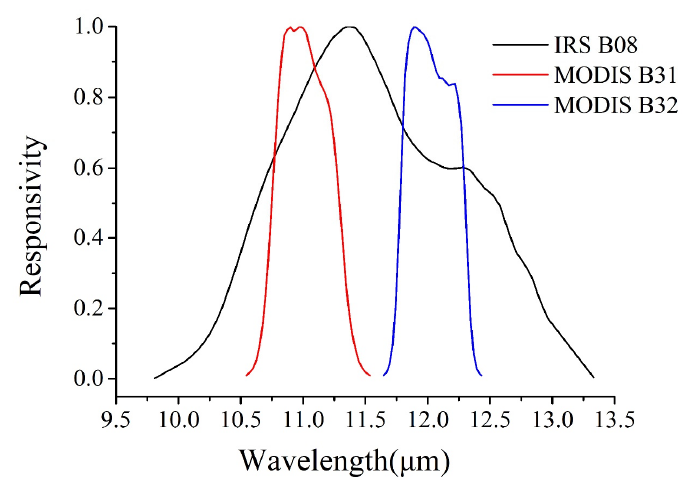
Figure 2. Comparison of channel response functions between Terra/MODIS B31 and B32 and the HJ- 1B/IRS B08. Table 1. Comparison of selected thermal band features of the infrared sensor (IRS) and moderate- resolution imaging spectroradiometer (MODIS).